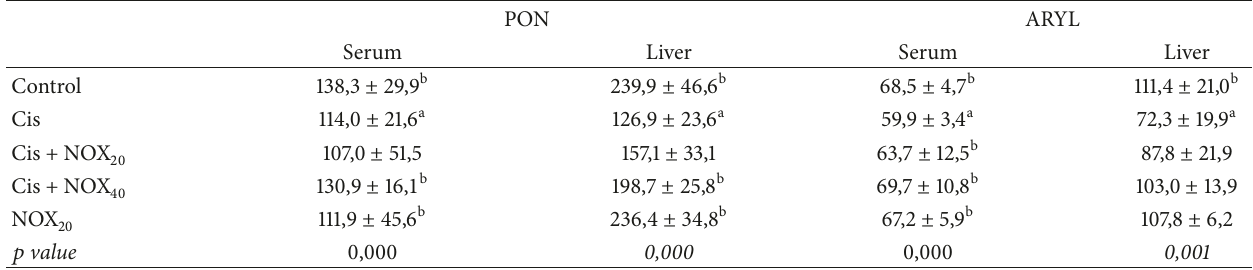
Table 3: Effects of cisplatin (7mg/kg), naringenin oxime (20mg/kg) (NOX 20 ), Cis + NOX 20 , and Cis + NOX 40 on paraoxonase (PON) and arylesterase (ARYL) in serum and liver of rats.